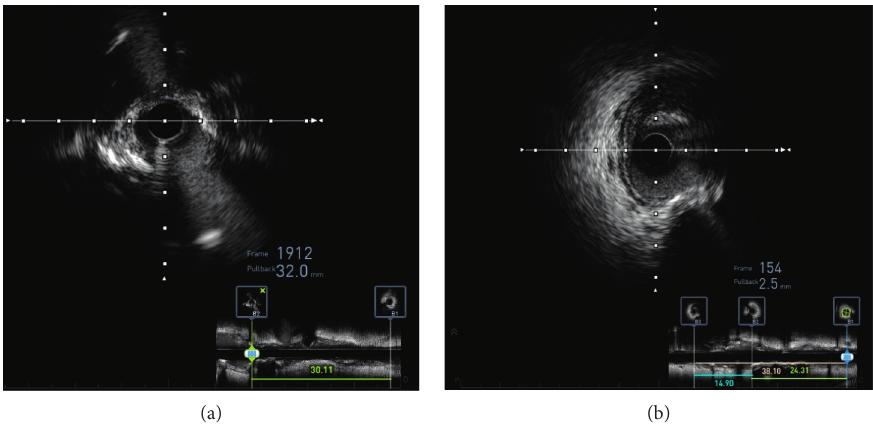
Figure 1: (a) IVUS image showing lesion length measurement from ostium of LAD to distal landing zone. In the IVUS picture above, we can see the wire in the LCX which is relatively free of disease. (b) Length measurements when two stents are planned, particularly when there is gross size discrepancy between proximal and distal landing